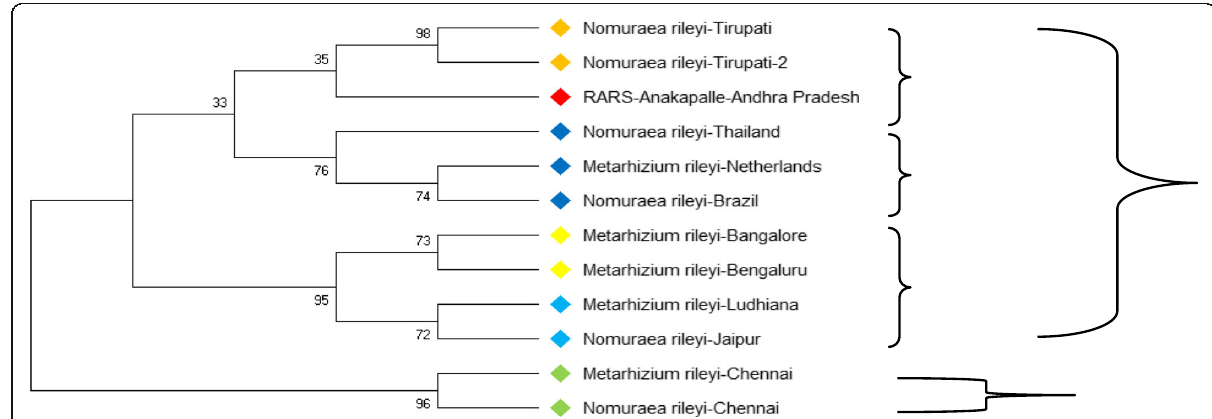
Fig. 6 Phylogenetic tree based on the nucleotide sequences of ITS region of isolated fungus (RARS, Anakapalle) with relevant sequences of Nomuraea rileyi from NCBI